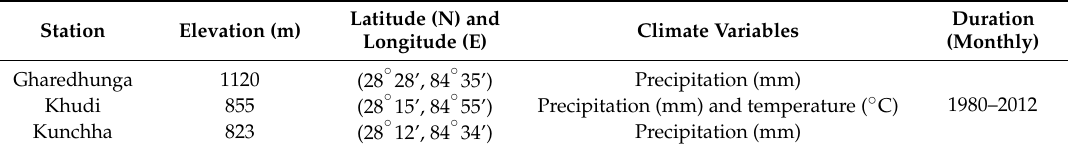
Table 1. Considered climatic data.